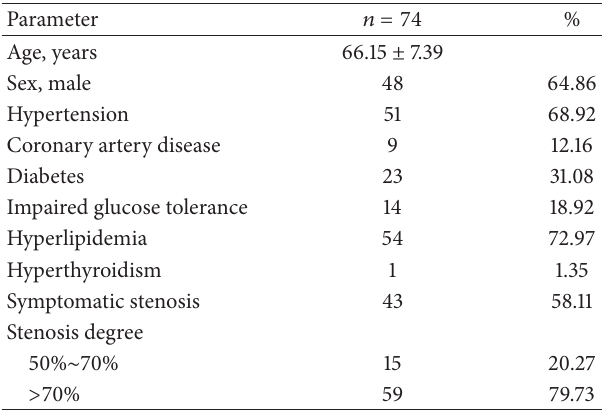
Table 1: Baseline characteristics of patients scheduled for